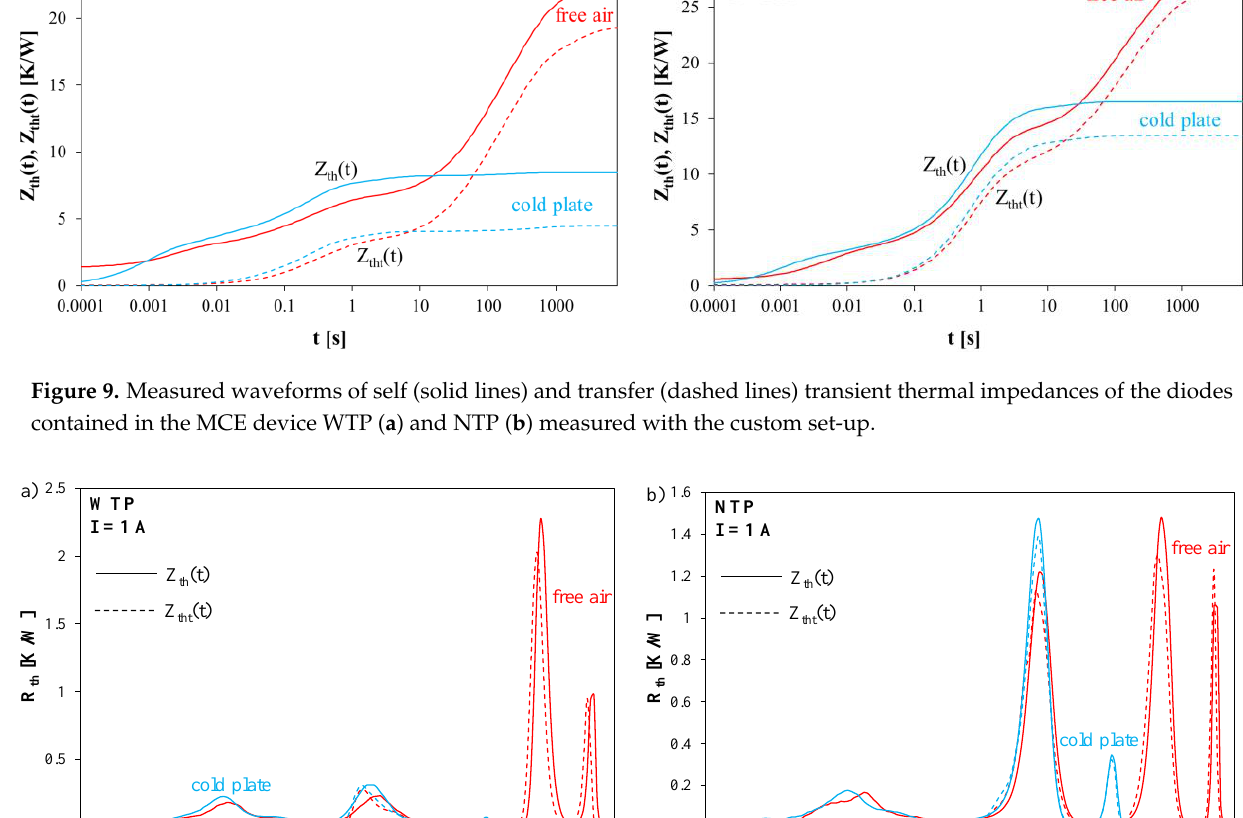
Figure 10. Spectra of thermal time constants determined using the MASTER software on the basis of the measured wave- forms of self (solid lines) and transfer (dashed lines) transient thermal impedances of the dies contained in the MCE device WTP ( a ) and NTP ( b ) measured by the T3Ster set-up.